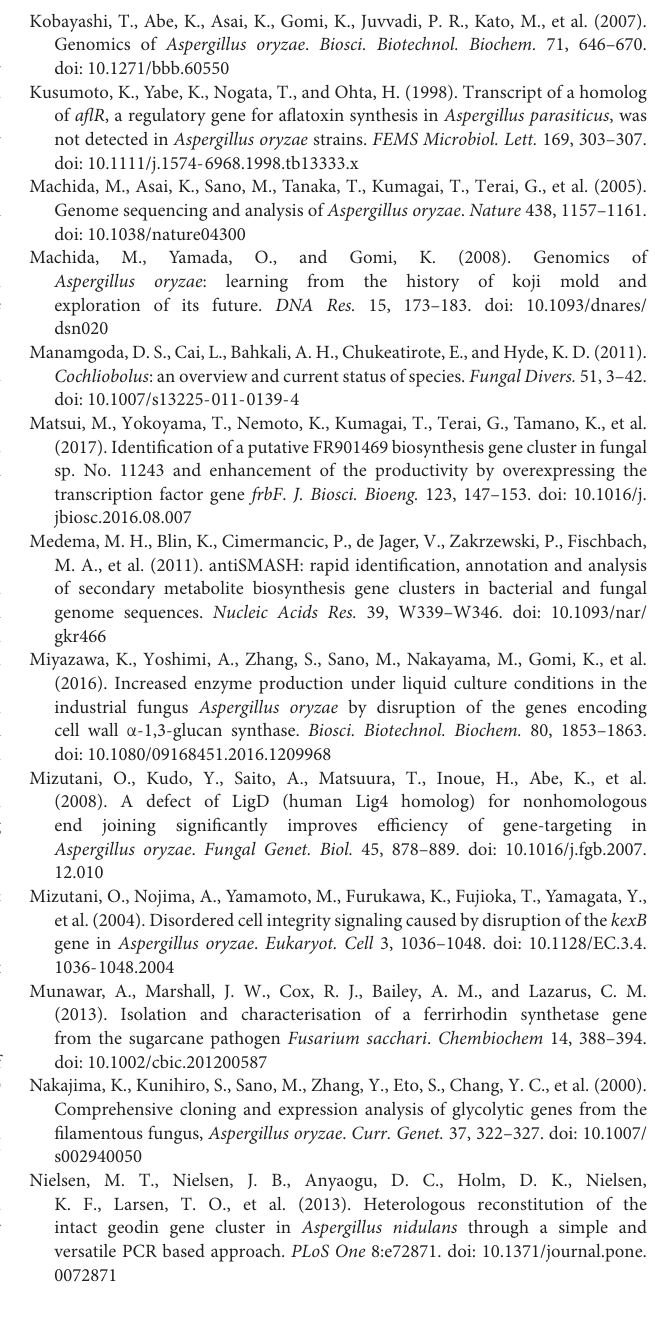
evaluated as the average values of the inhibition halos of the test fungus. ACN, acetonitrile. FIGURE S6 | Extracted ion chromatograms ( m/z 1113) and mass spectra of KK-1 derived from strains 3, 9, and 56. (A,C,E) Extracted ion chromatograms ( m/z 1113) of extracts of supernatants from culture of Aspergillus oryzae strains 3 (A) , 9 (C) , and 56 (E) . (B,D,F) Mass spectra of KK-1 in extracts of supernatants from culture of A. oryzae strains 3 (B) , 9 (D) , and 56 (F) . TABLE S1 | Primers used in this